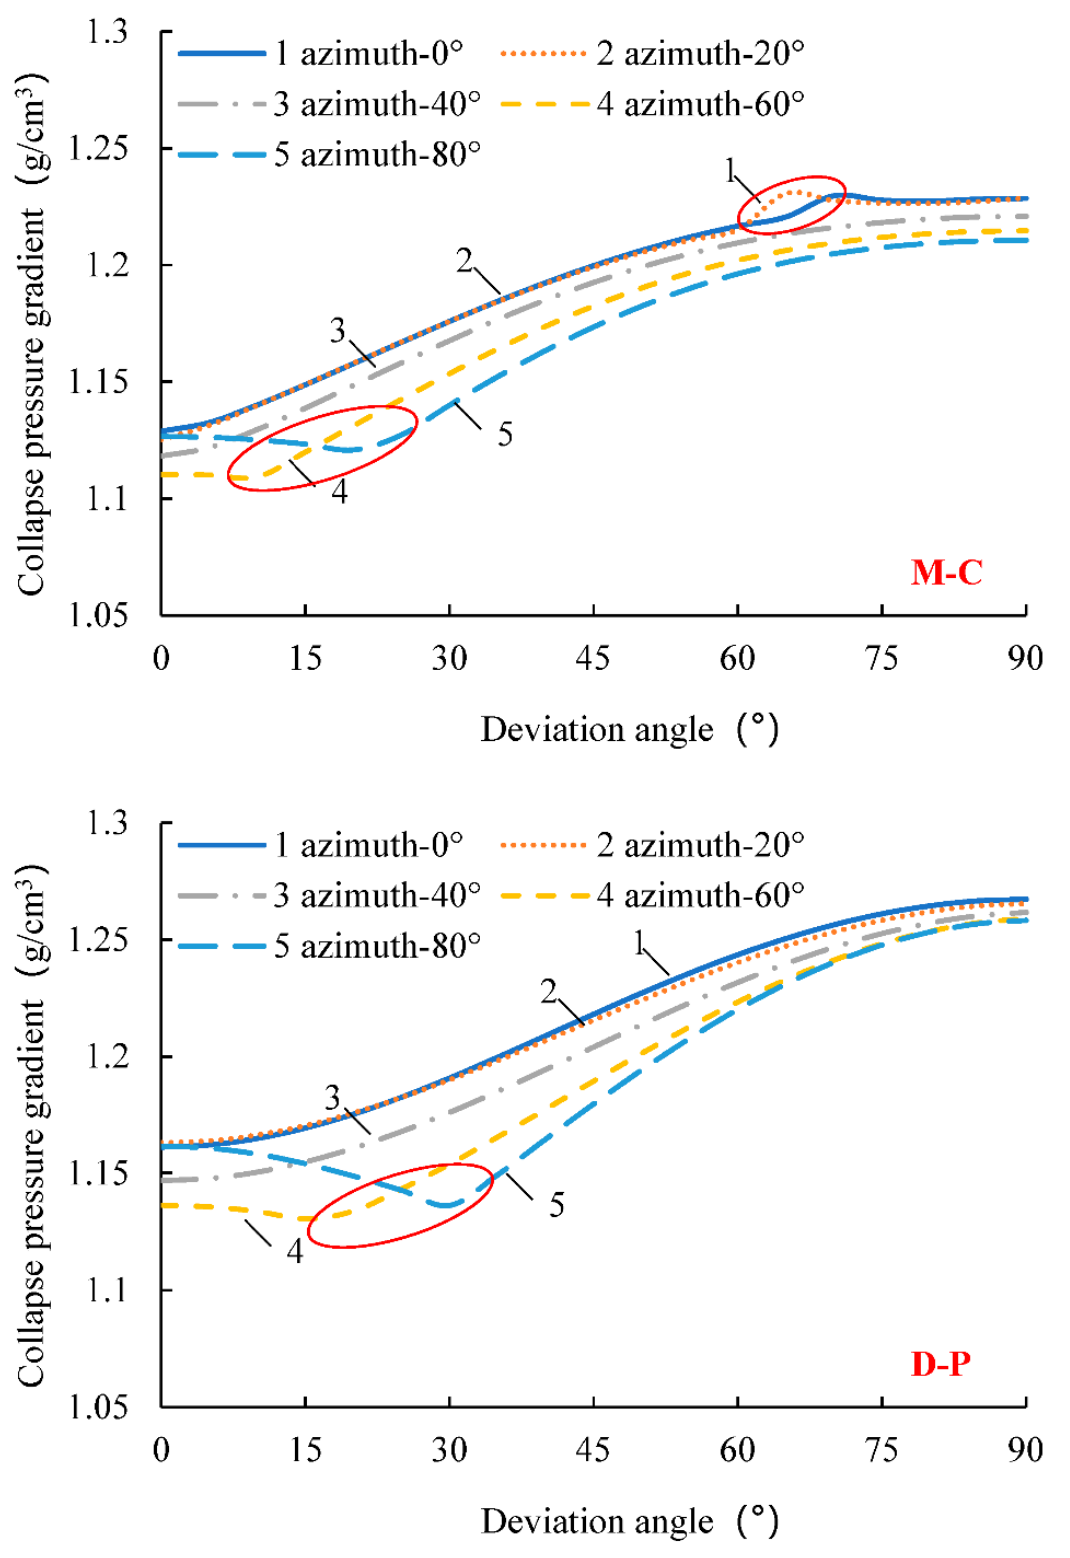
Figure 8. The deviation angle and the collapse pressure gradient relationship curves by the two criteria.